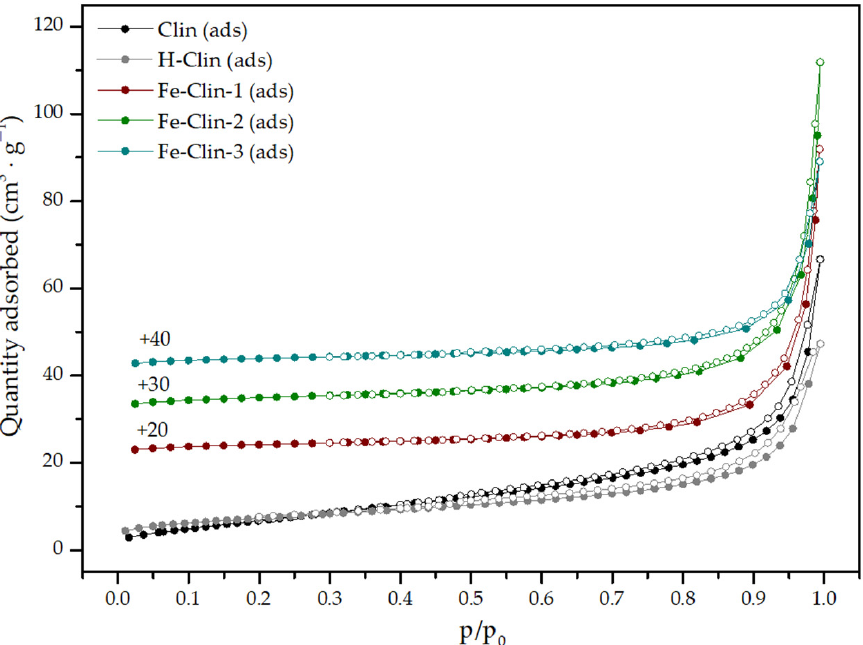
Figure 2. Low-temperature N 2 adsorption–desorption isotherms obtained for raw clinoptilolite (Clin) and the investigated catalysts (for better visibility, the isotherms were shifted by the values given in the figure). Table 2. Textural and structural parameters of raw clinoptilolite and the Fe-clinoptilolite catalysts. Sample